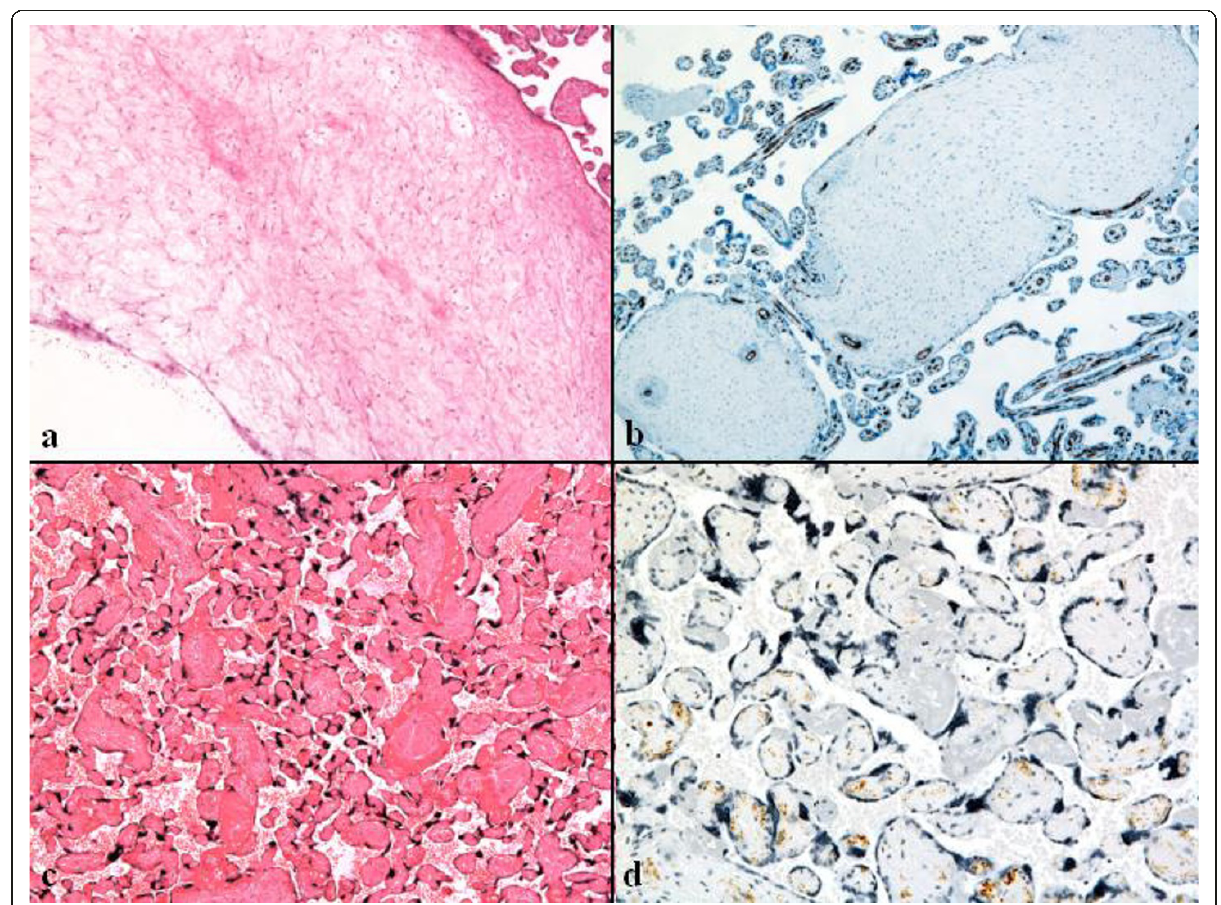
Figure 5 Histopathology and immunohistochemistry of abnormal villi . a) Hydropic stem villi and diminished vessels at the affected lesion of the placenta. (HE, objective ×4). The lower left empty corner shows a cystic cavity of the hydropic stem villus. b) Decrease in both number and size of vessels by the CD34 immunohistochemical staining. (objective ×4). c) Avascular terminal villi in a part of the affected area. (HE, objective ×10). d) Scatter and disappearance of immunohistochemical CD34-positive endothelial cells in the avascular terminal villi (objective